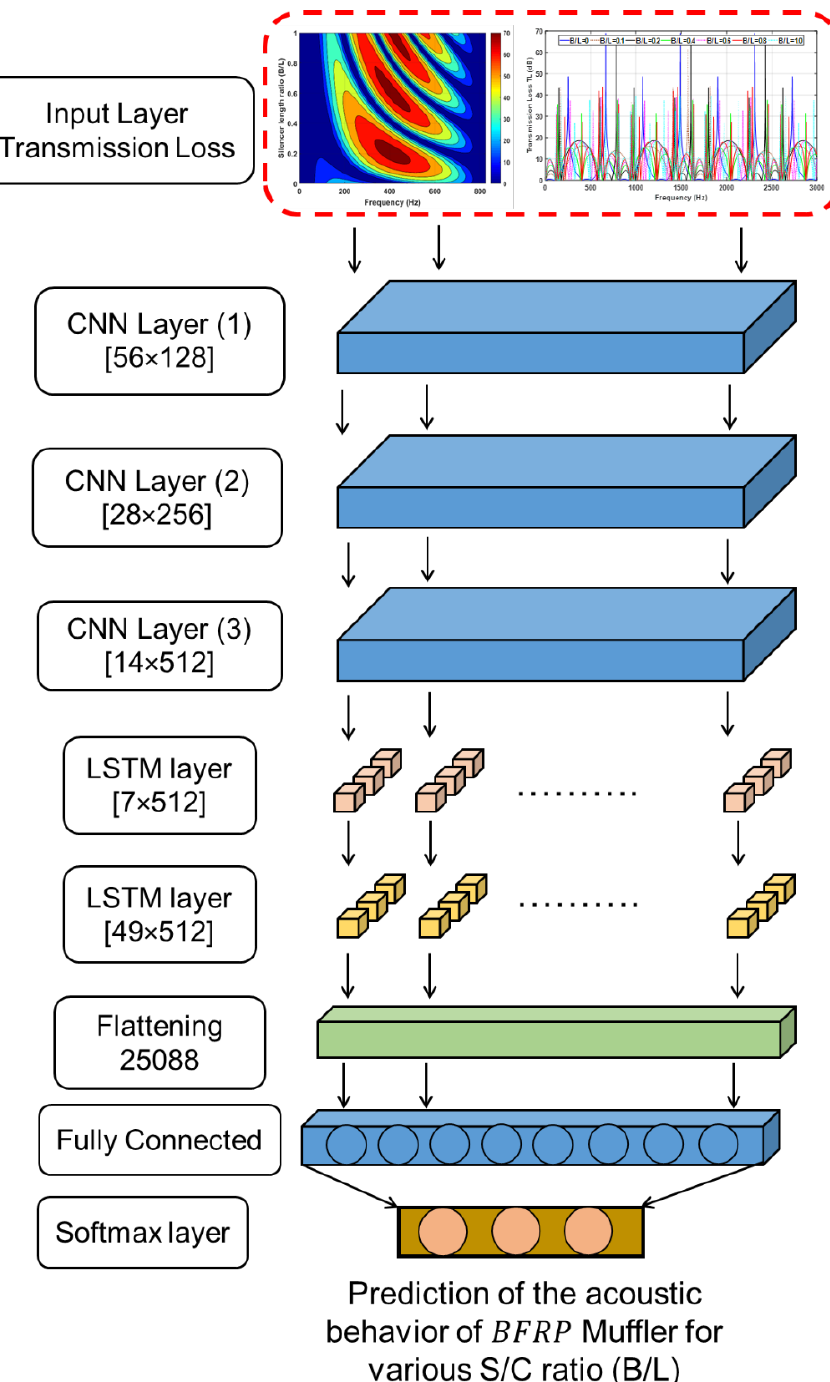
Figure 15. The three 1D convolutions’ full connection layer (FC) layers, two sub-sampling LSTM layers, and a softmax layer Deep Neural Network.